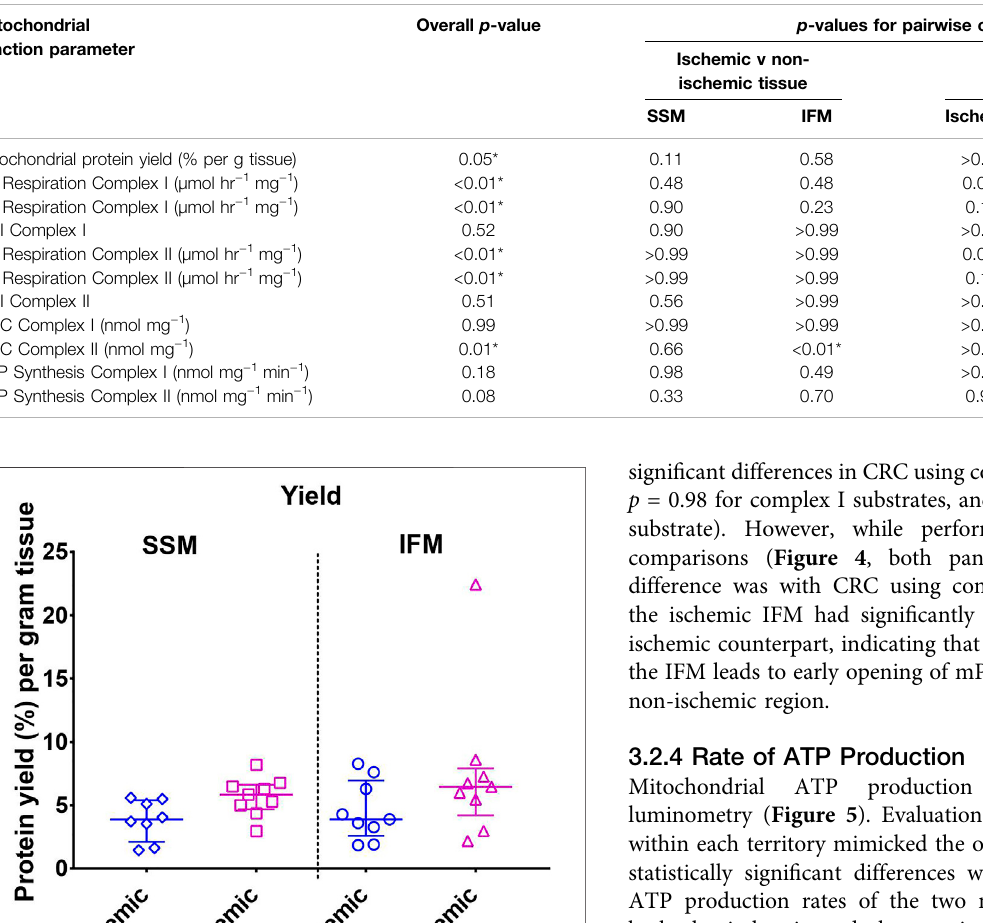
TABLE 2 | p -values for overall and all between-group comparisons of mitochondrial function tests between cardiac SSM and IFM within the ischemic (LAD) and non- ischemic (Circ) regionsofthe saline treatedheartdisplayed in fi gures 2to5. Overall p -valuewasobtained through Friedman ’ snon-parametrictest; pairwise comparison p -values were obtained through Dunn ’ s test.